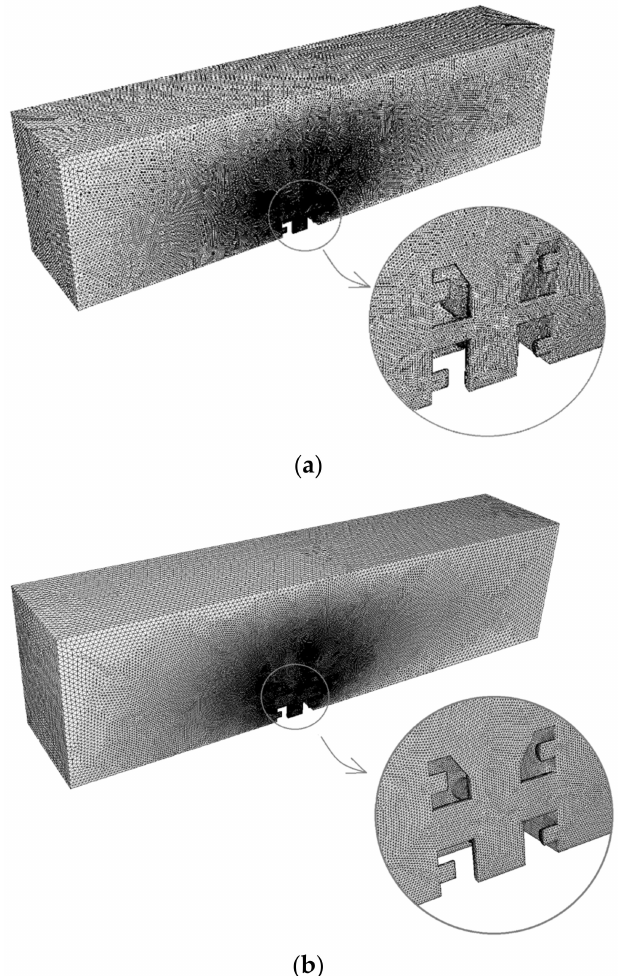
Figure 5. Computational mesh; ( a ) orientation A; ( b ) orientation B.